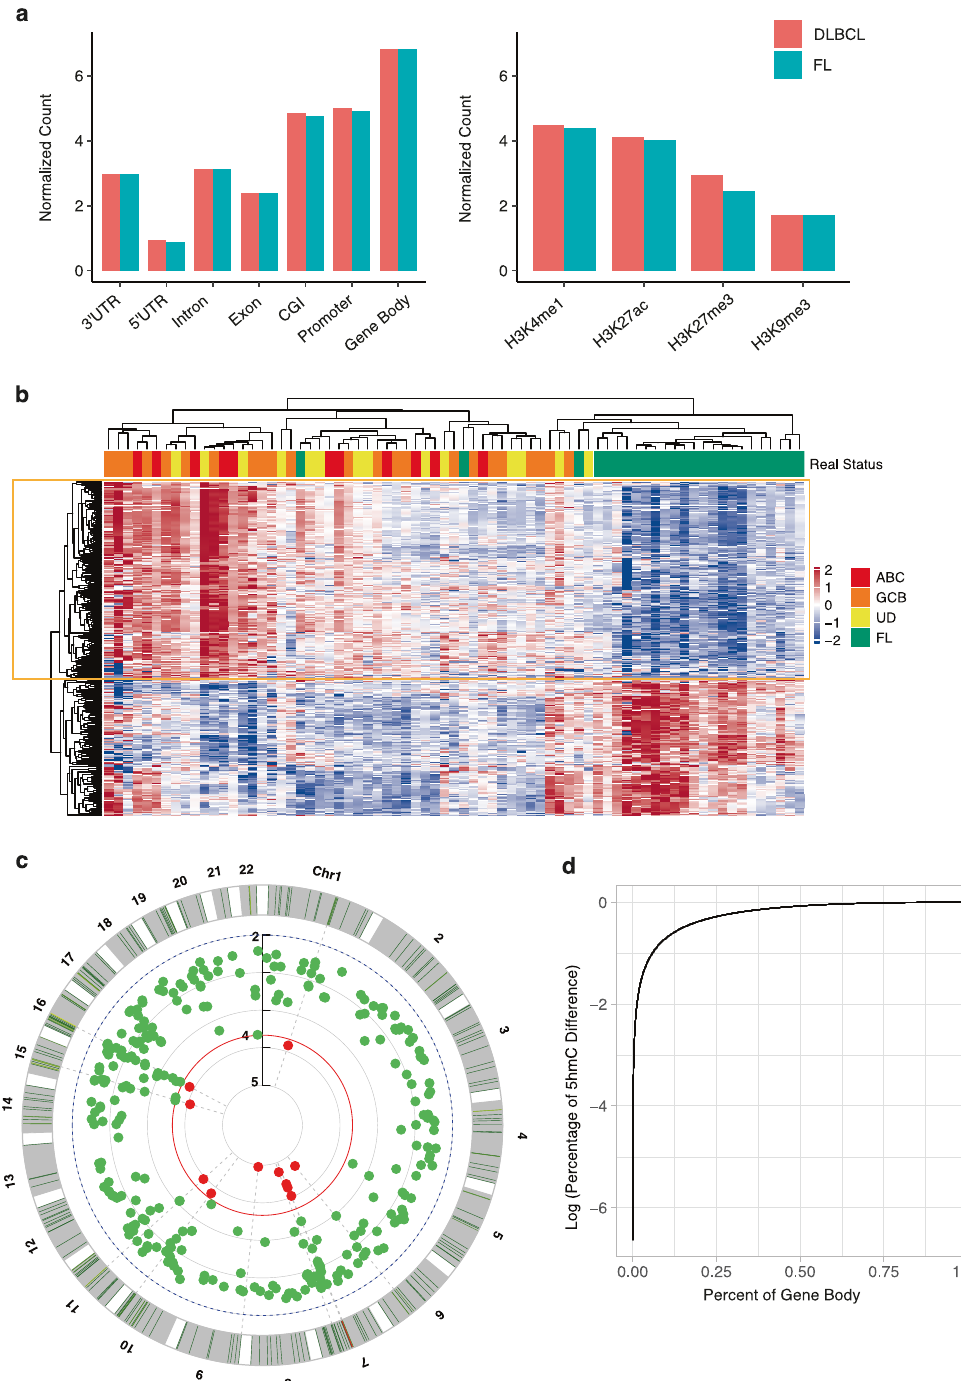
Fig. 1 Overview of 5hmC in cfDNA between DLBCL and FL. a Normalized counts of 5hmC reads show distinct distributions in the human genome. b The 294 differentially modi fi ed genes between DLBCL and FL are shown. c The distribution of the 294 differentially modi fi ed genes between DLBCL and FL is shown across the human genome. d A small proportion of genes drive the overall differential modi fi cation between DLBCL and FL. Red indicates differentially modi fi ed genes with P -value < 1 × 10 − 4 . 3 ′ TR 3 ′ untranslated region, 5 ′ UTR 5 ′ untranslated region, CGI CpG islands, DLBCL diffuse large B-cell lymphoma, FL follicular lymphoma, UD DLBCL of unknown cell-of-origin, GCB germinal center B-cell-like DLBCL, ABC activated B-cell-like